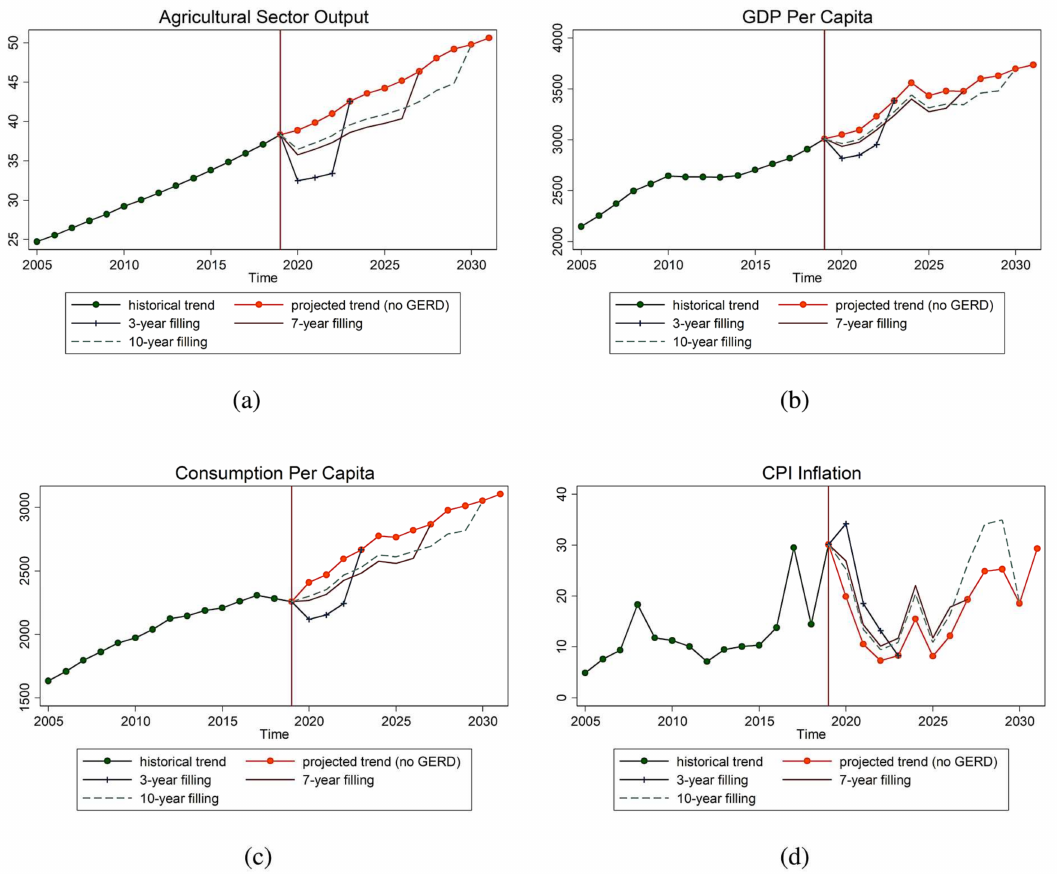
Figure 5. Projected trends in ( a ) agricultural sector output (billion $), ( b ) GDP per capita, ( c ) con- sumption per capita, and ( d ) CPI inflation under the alternative filling scenarios.